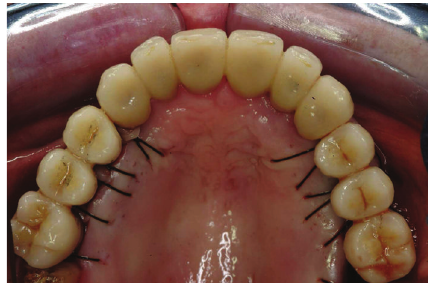
Figure 31: Delivery of the second set of temporaries and extractions of teeth 17 and 27 according to the treatment plan.